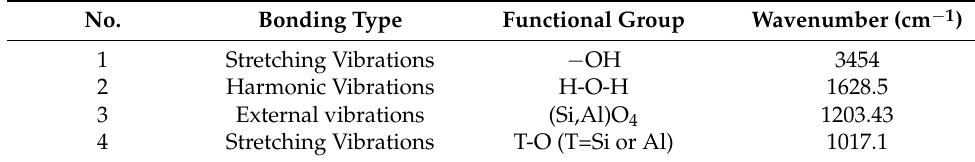
Figure 7. The FTIR spectrum of NZ, PZ, and SZ. Table 2. The functional groups present in the natural zeolite.